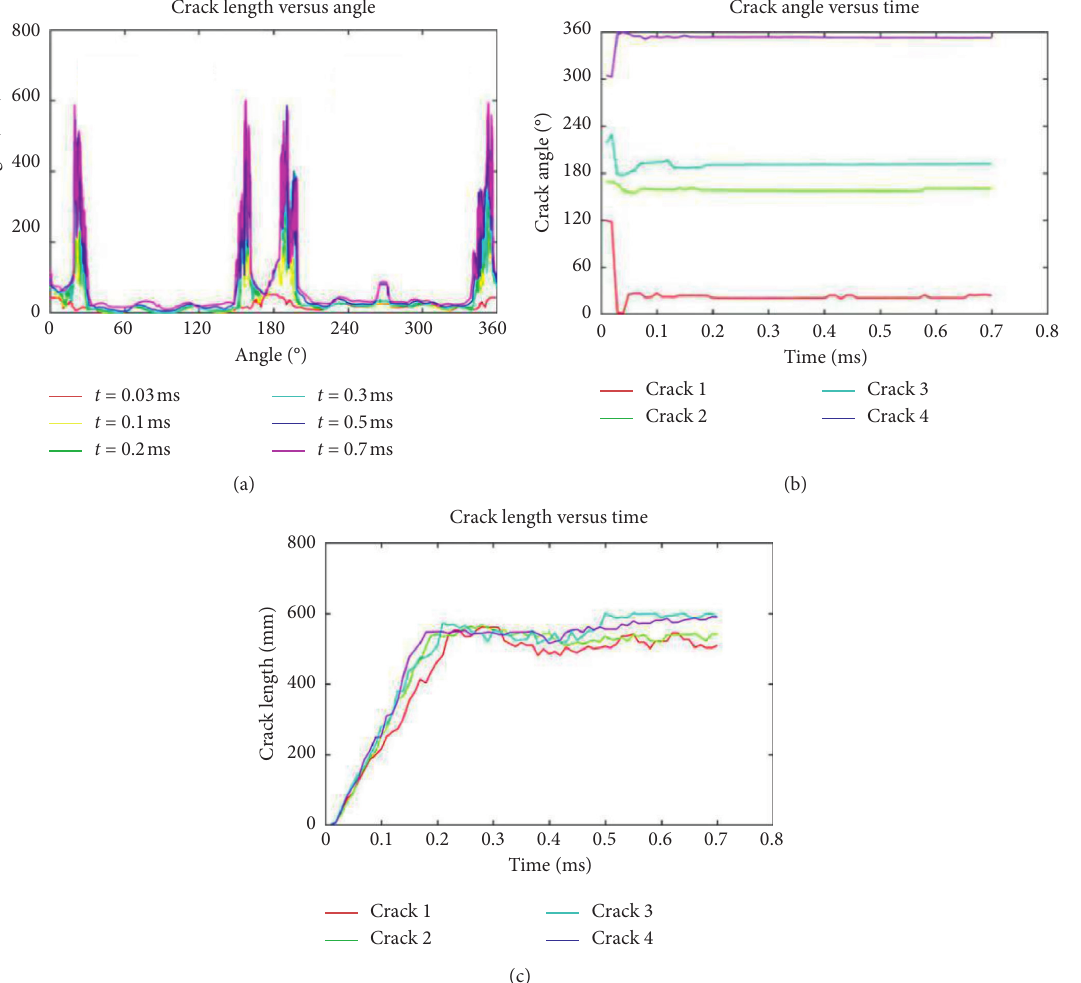
Figure 12: Schematic diagram of 35 ° shaped energy blasting crack. (a) Crack angle versus crack length for 35 ° shaped energy angle. (b) Time evaluation of crack angle for 35 ° shaped energy angle. (c) Time evaluation of crack length for 35 ° shaped energy